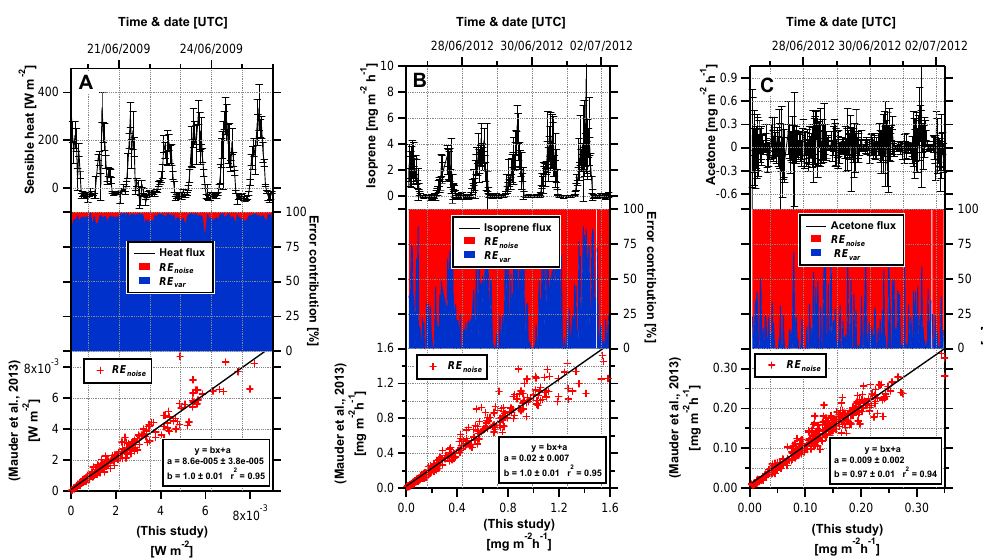
Figure 5. Sensible heat (a) , isoprene (b) and acetone (c) fluxes and accompanying errors. Upper panels show the measured fluxes with error bars denoting the total random error (RE). The central panels show how the total random error can be divided into errors associated with instrument noise (red, RE noise ) and the variability in turbulence at the genuine atmospheric concentration (blue, RE var ) . The lower panels show scatter plots of the random instrument noise calculated using the analytical approximation of Mauder et al. (2013) and the numerical method outlined in this study.